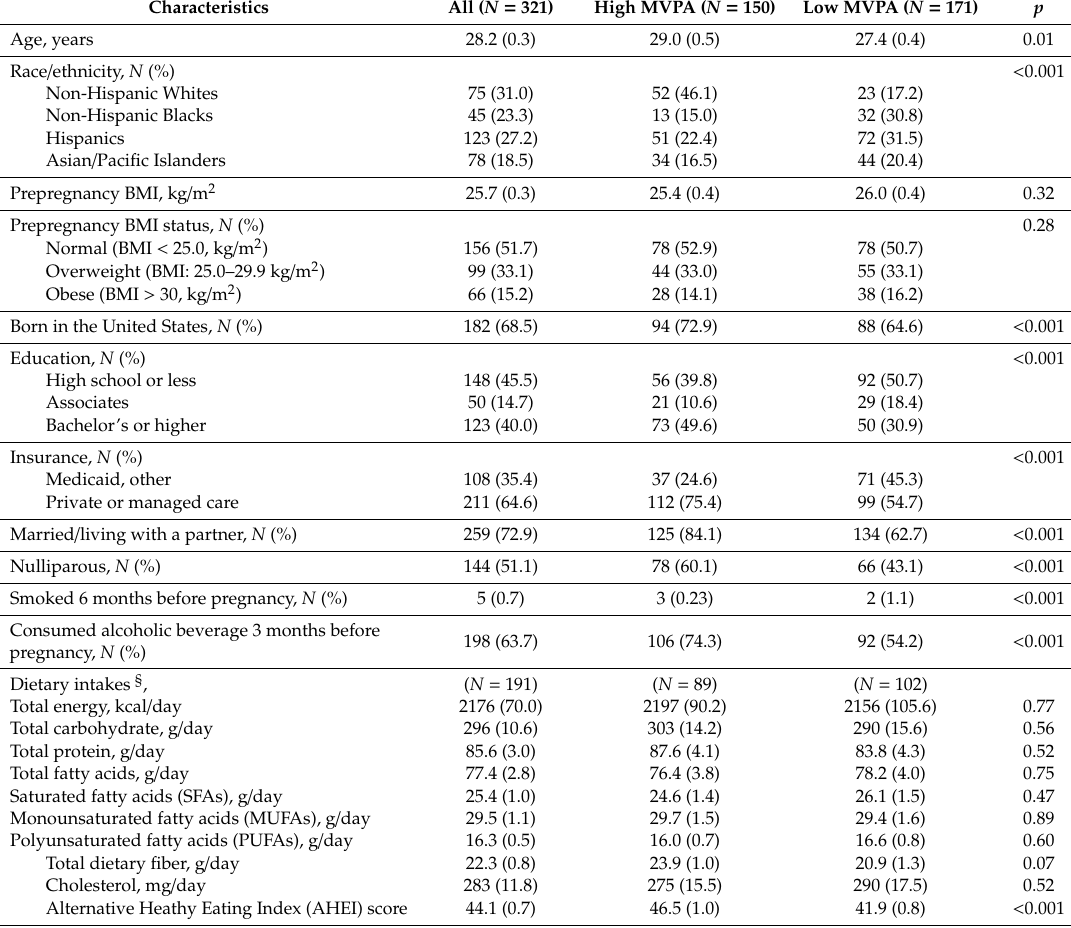
Table 1. Characteristics of pregnant women by moderate-to-vigorous physical activity (MVPA) at visit 0 (8–13 gestational weeks) in the National Institute of Child Health and Human Development (NICHD) Fetal Growth Studies—Singleton